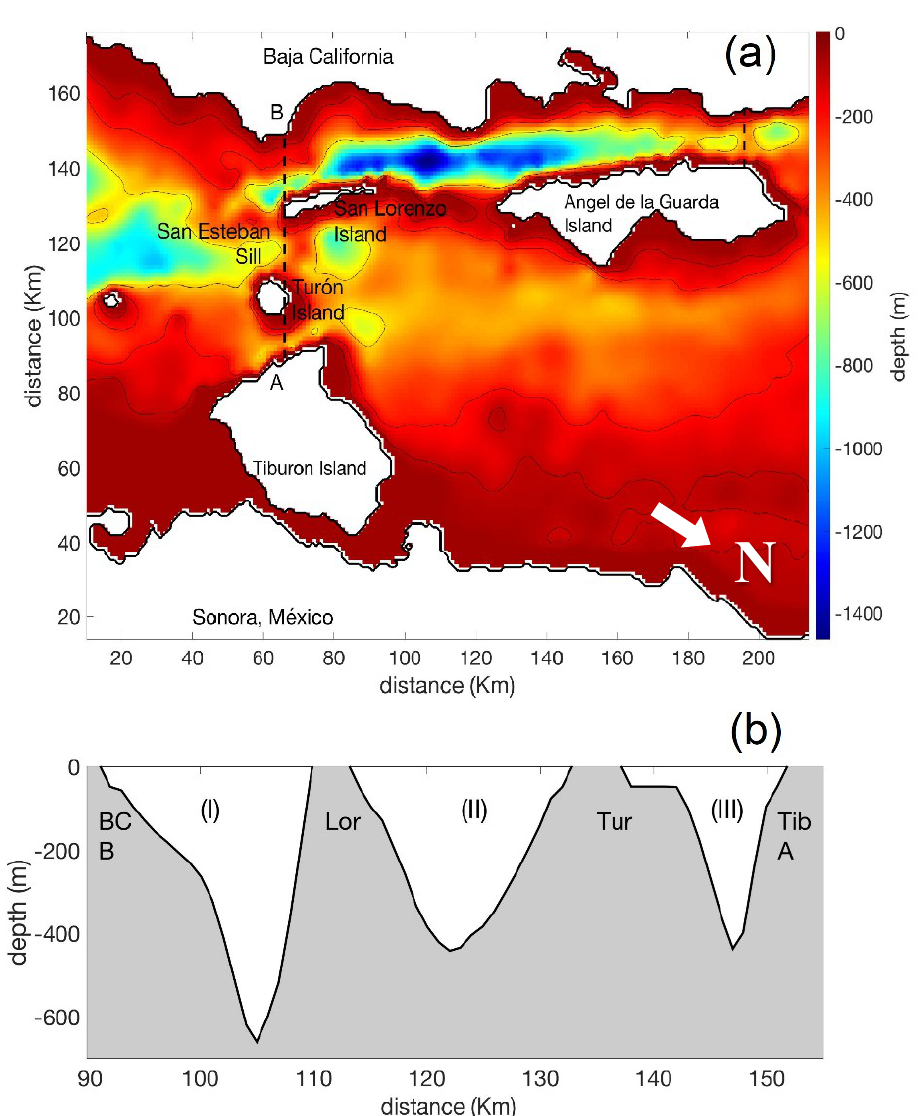
represent the general scenario for inflow and outflow currents, on the assumption that temporary variations only increase or decrease the intensity of the values but not the spatial variability in depth. For detailed numerical model validation, see [22].